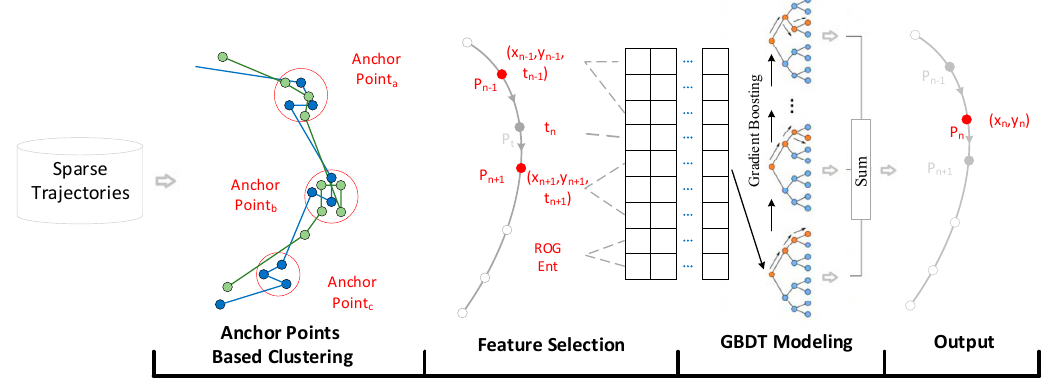
Figure 4. Architecture of the trajectory reconstruction algorithm.